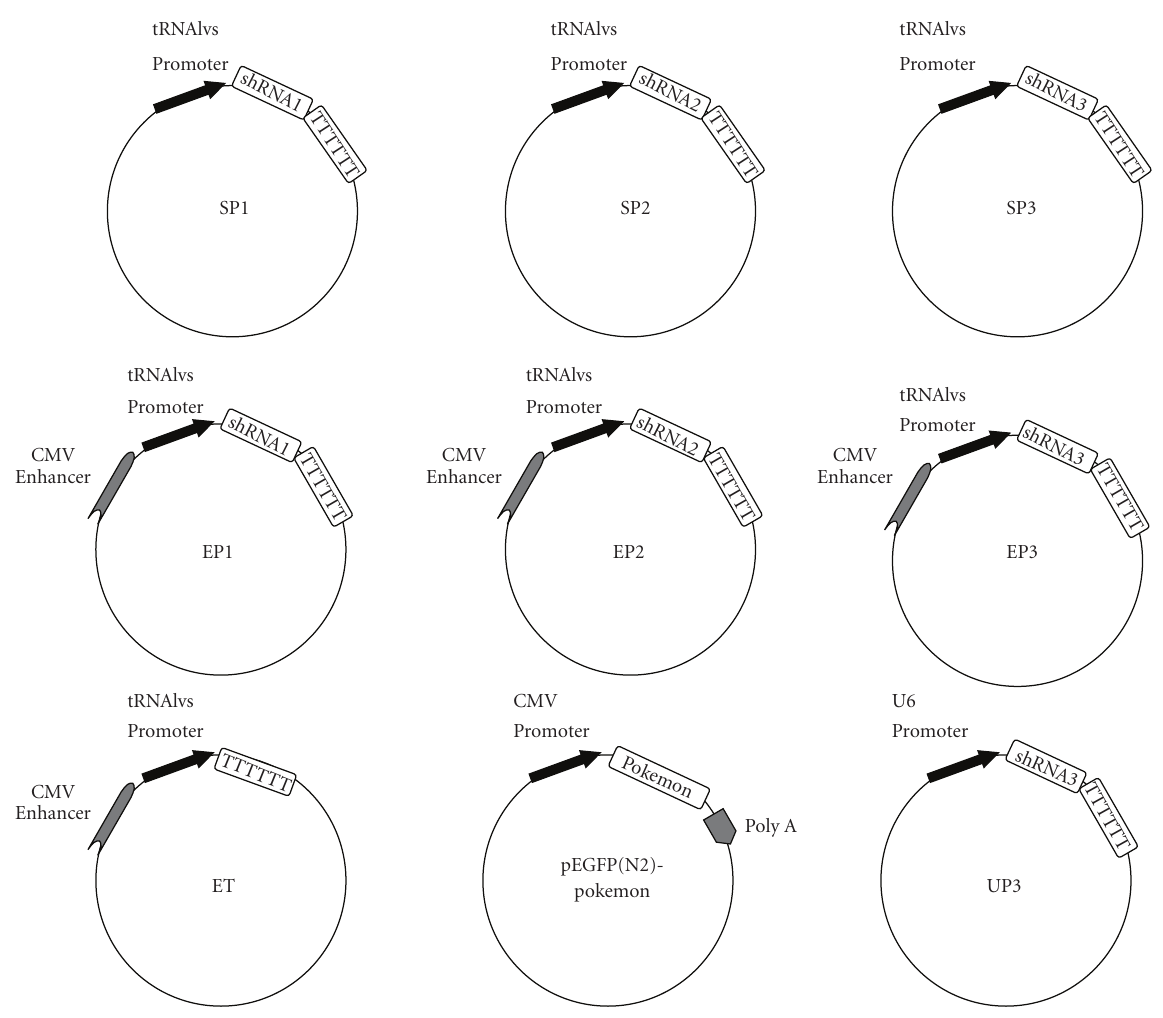
Figure 1: Map of construscts used in this work. SP1, SP2 and SP3 plasmids derived from the pSiler plasmid can express shRNA1, shRNA2, and shRNA3, respectively. EP1, EP2 and EP3 plasmids derived from the pExsiler plasmid can express shRNA1, shRNA2, and shRNA3, respectively. UP3 plasmid derived from pBS/U6 plasmid can express shRNA3. As control, ET plasmid derived from the pExsiler plasmid can express no shRNA. pEGFP(N2)-Pokemon derived from pEGFP-N2 vector can express Pokemon-GFP fusion